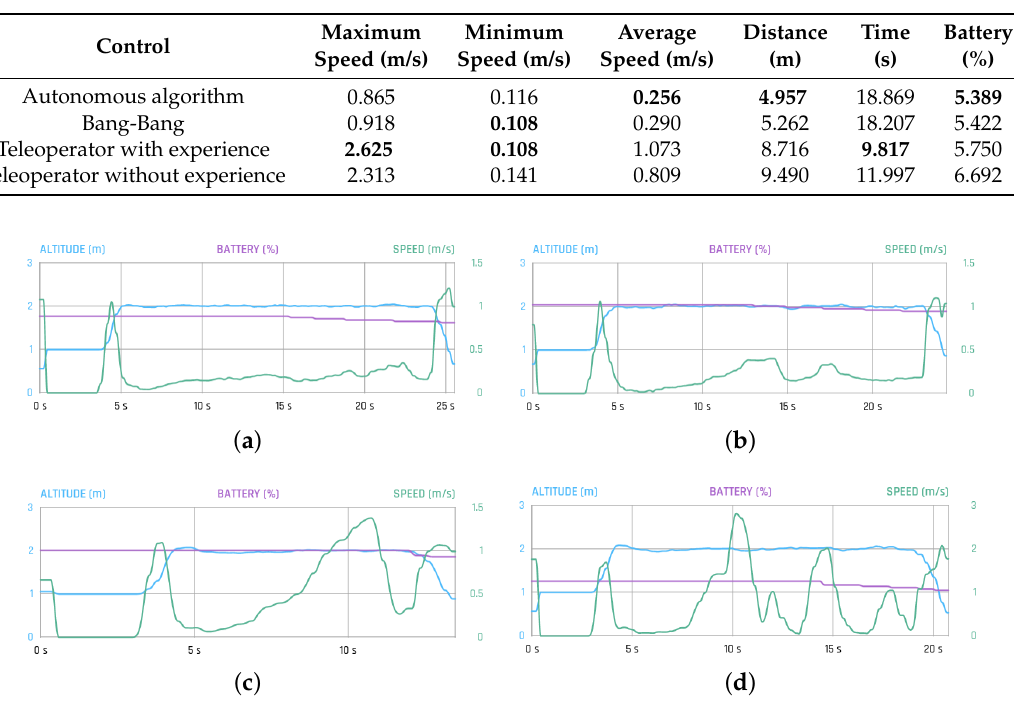
Table 1. One fixed obstacle.